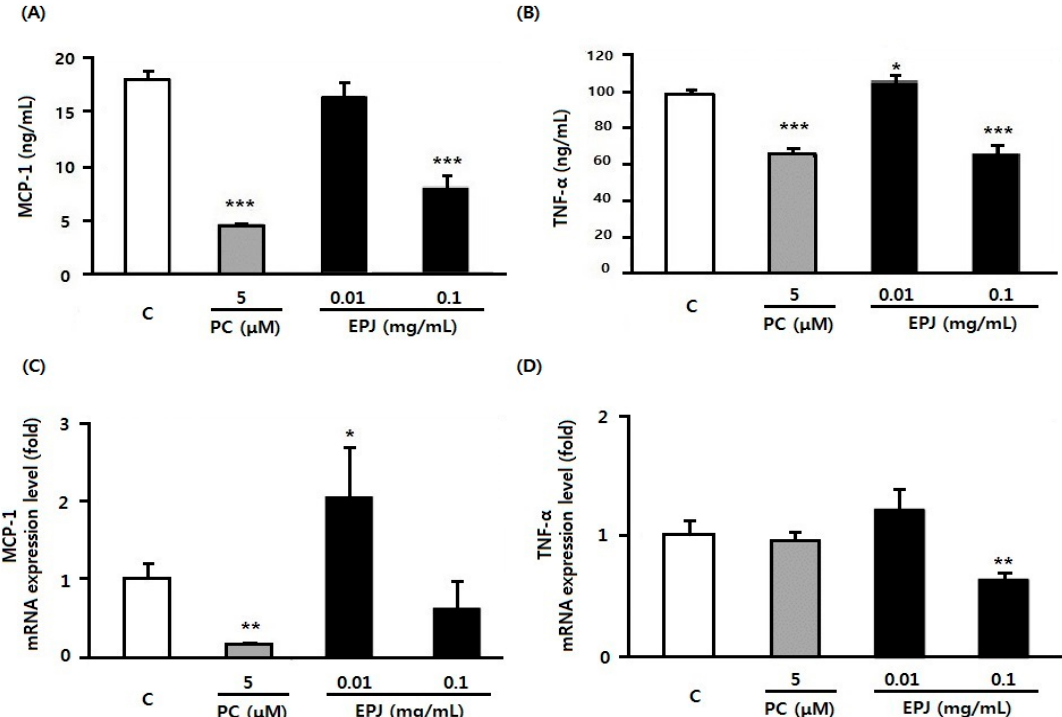
Figure 2. EPJ decreases the secretion and mRNA expression of MCP-1 and TNF α in LPS-stimulated RAW264.7 macrophages ( A – D ). Protein ( A , B ) and mRNA quantification ( C , D ) were performed. MCP-1 and TNF α expression were evaluated using glyceraldehydes 3-phosphate dehydrogenase (GAPDH) as the endogenous control gene. Troglitazone (5 µ M) was used as the positive control. The three treatment groups (PC and both of EPJ groups) were compared with the control ( C ) group. Data are mean ± S.D. of four independent determinations. * p < 0.05, ** p < 0.01, *** p < 0.001.